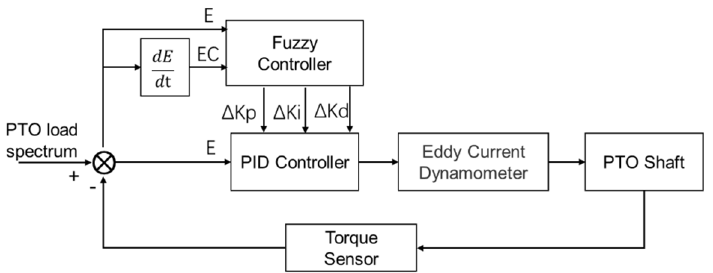
Figure 6. The principle of Fuzzy-Proportional-Integral-Derivative (Fuzzy-PID) controller.